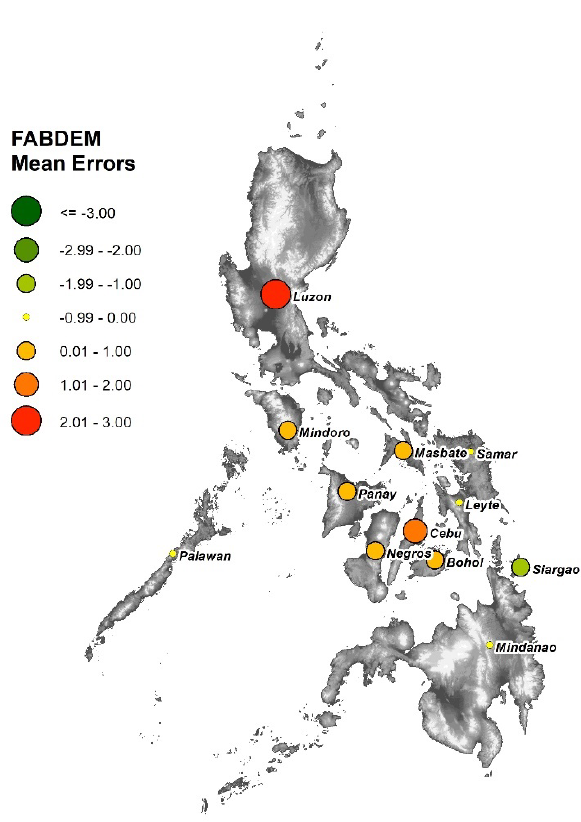
Figure 6. FABDEM mean errors at selected islands of the Philippines. The values illustrated are the average of the mean errors calculated from the three sets of GCPs.